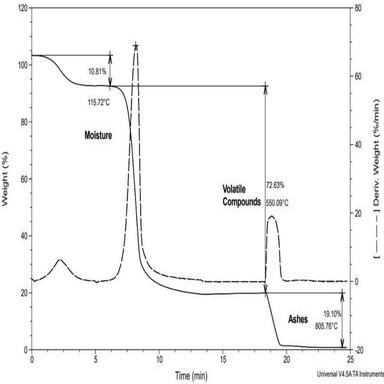
Results of the thermal stability test.